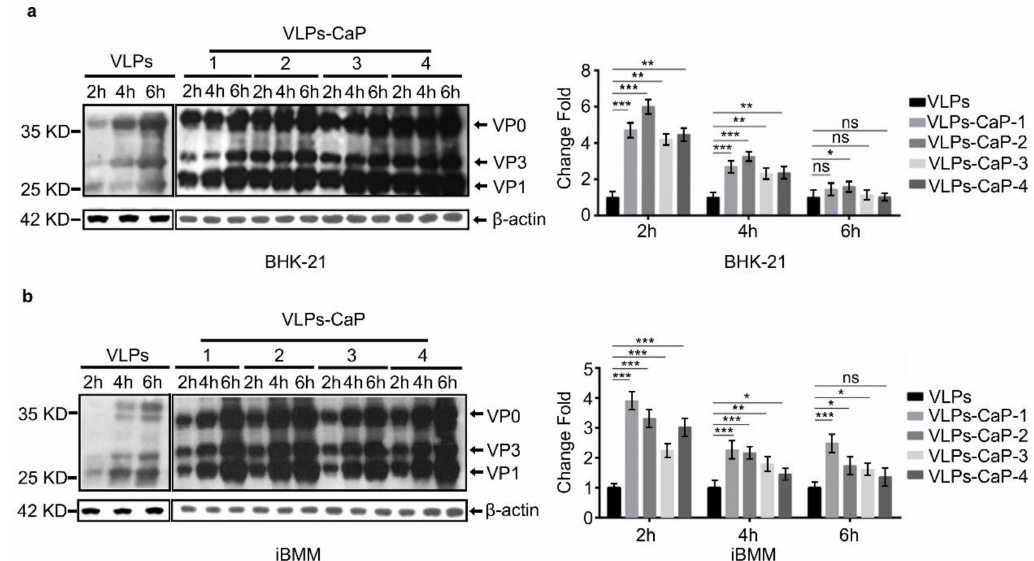
Figure 3. Cellular uptake of the VLPs-CaP complexes as quantified by western blot analysis. The BHK-21 cells ( a ) and iBMM cells ( b ) were treated with 5 µ g of different VLPs for 2, 4, and 6 h to analyze the effect of biomineralization on cellular uptake. Multiple comparisons were performed using one-way ANOVA, followed by Bonferroni (cid:48) s post-test, and p values < 0.05 were considered. *, p < 0.05; *, p < 0.01; ***, p <